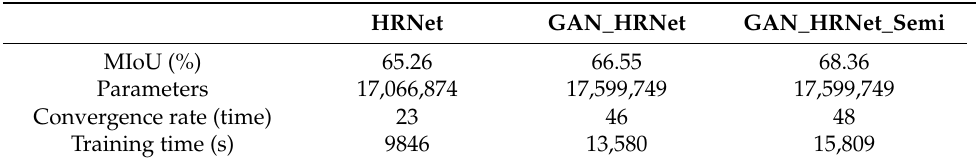
Table 3. Experimental results of the GAN-based semi-supervised semantic segmentation model.